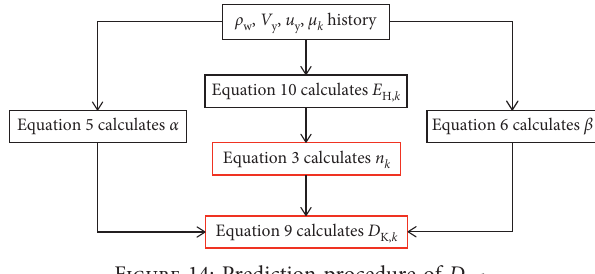
Figure 13: The process of the quasi-stable normalized effective amplitude for specimen R24. (a). The value of μ (b) Removal of the data points under the line of μ k � 1. (c) Averaging of the similar values of μ k .